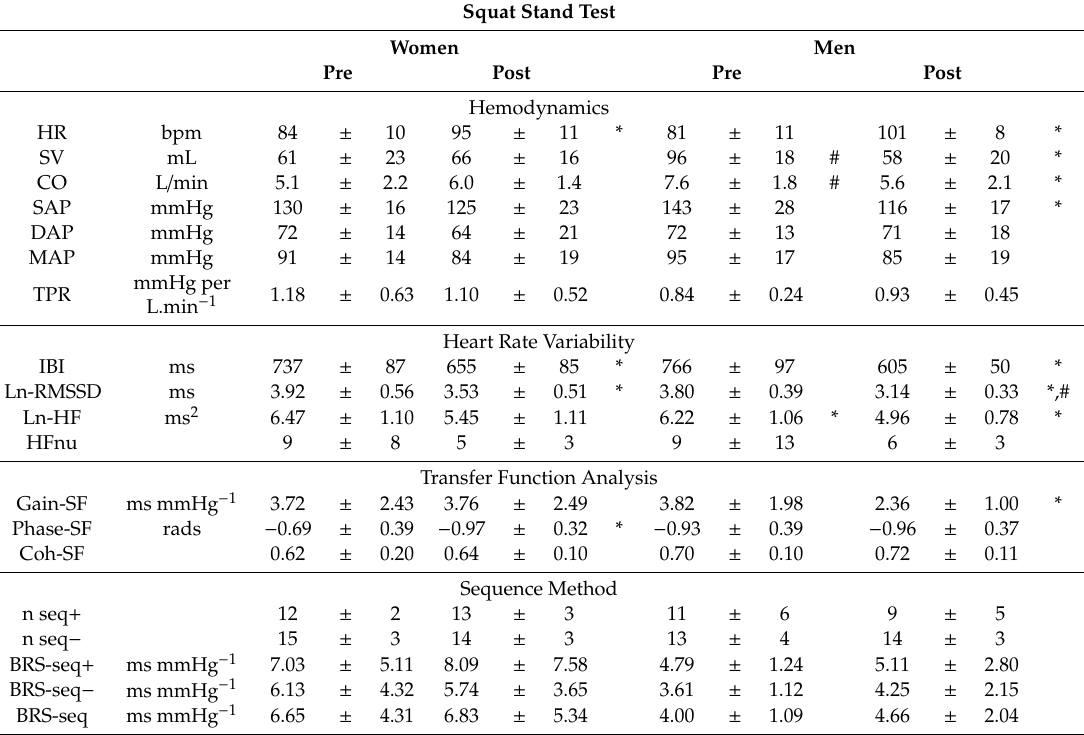
Table 2. Hemodynamic and baroreflex function variables before (Pre) and after (Post) the 21-km run in women and men during squat stand